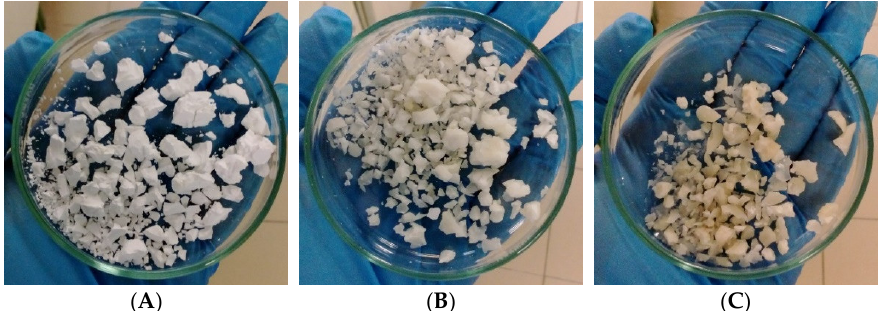
Figure 3. Images of the samples obtained after the SBW treatment of MMC biomass at ( A ) 150 °C, ( B ) 165 °C, and ( C ) 180 °C. ( B ) 165 ◦ C, and ( C ) 180 ◦